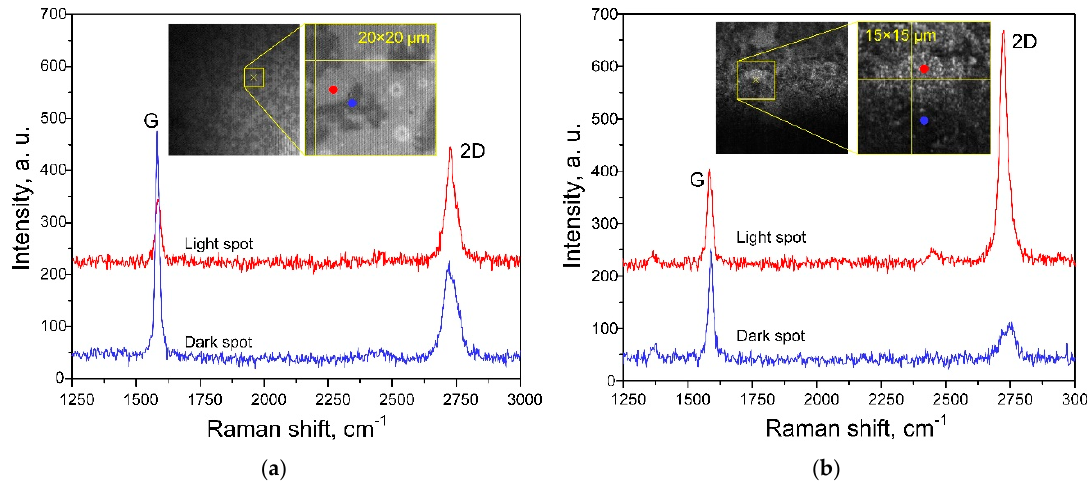
Figure 2. ( a ) Raman and ( b ) SERS spectra of graphene-containing film on the ( a ) c -Si and ( b ) silvered por -Si substrates registered in the light and dark spots. Insets show the Rayleigh images of the graphene-containing film.